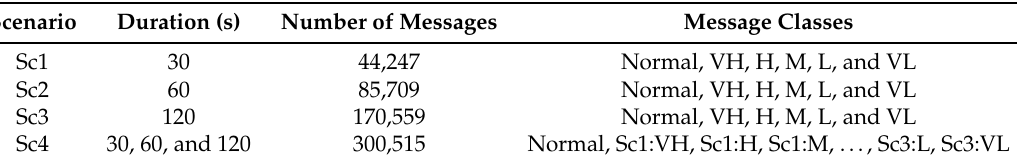
Table 1. The details of the